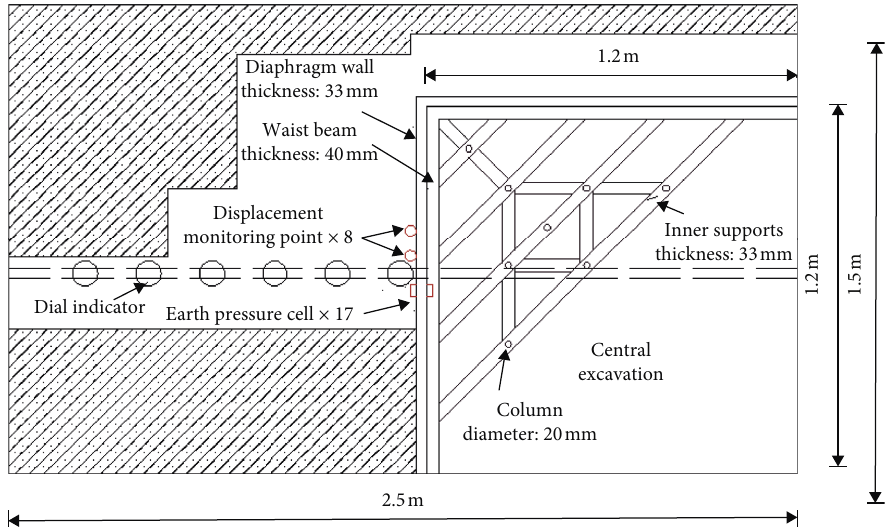
Figure 6: Overlooking